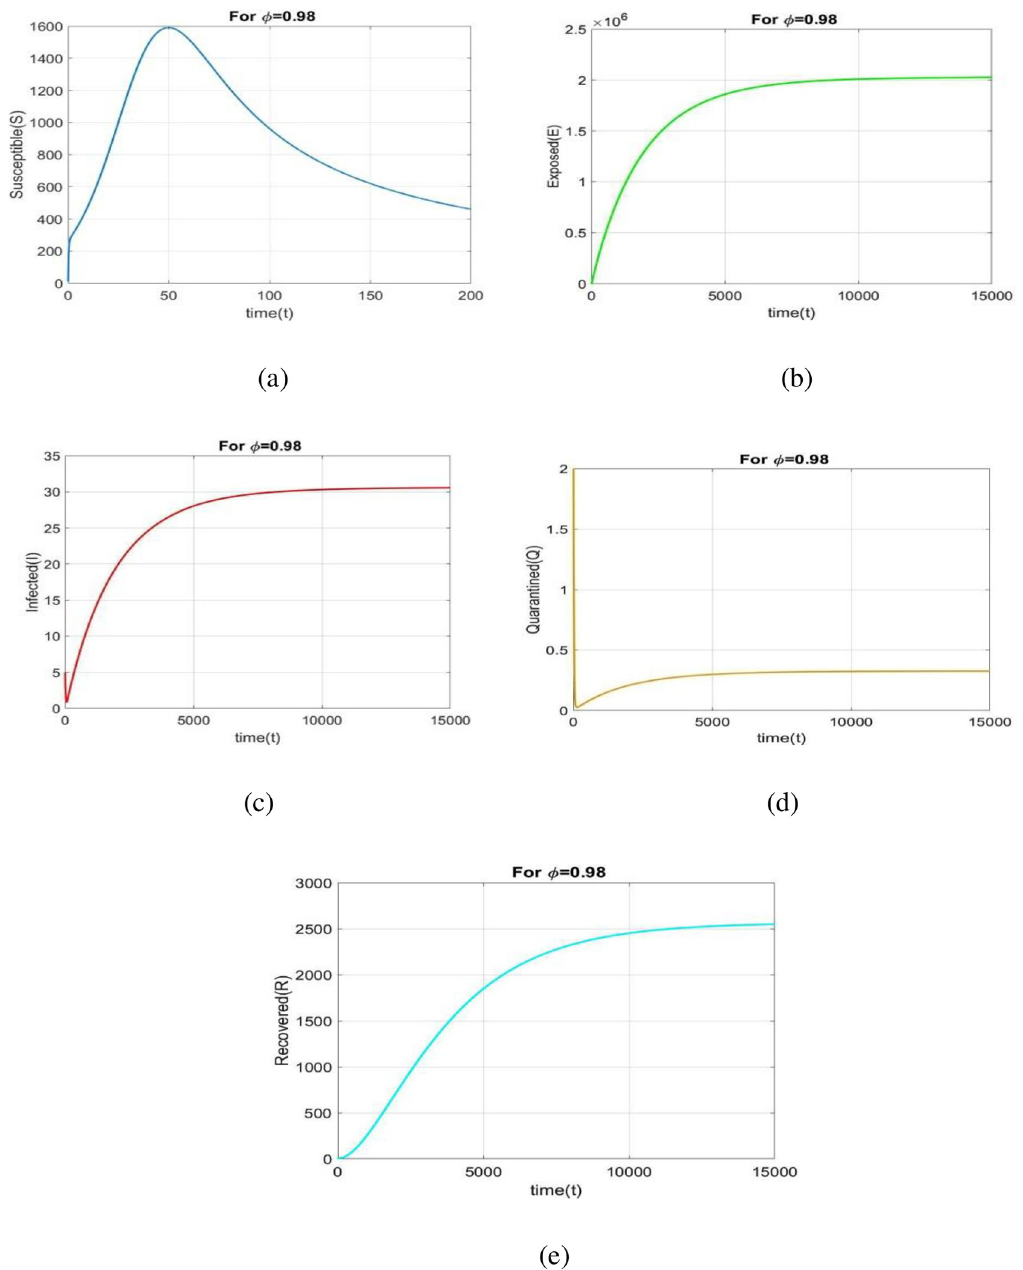
Fig 2. Time series solution. Time series of all classes correspondence to Table 2 taking ϕ = 0.98 of system